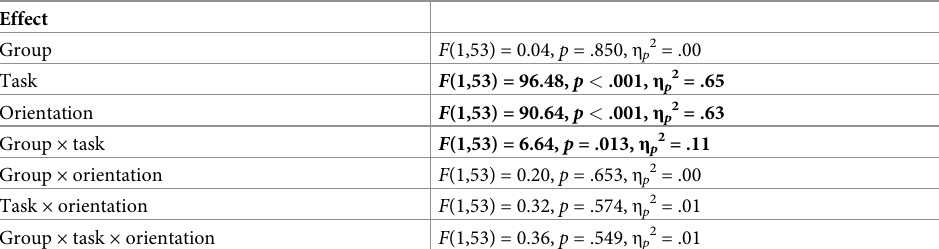
Table 2. Head IAs dwell time proportion comparisons.